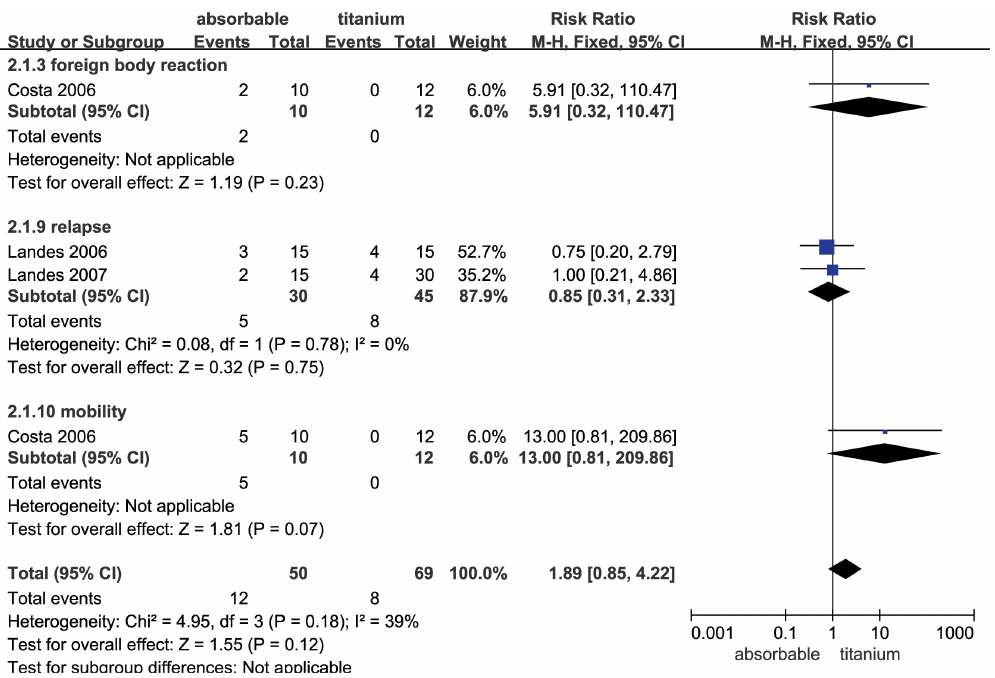
Figure 4. Forest plot of trials of absorbable fixation versus titanium examining the effect on relative risk of complications in bimaxillary operation. See Figure 2 legend for expansion of abbreviations.